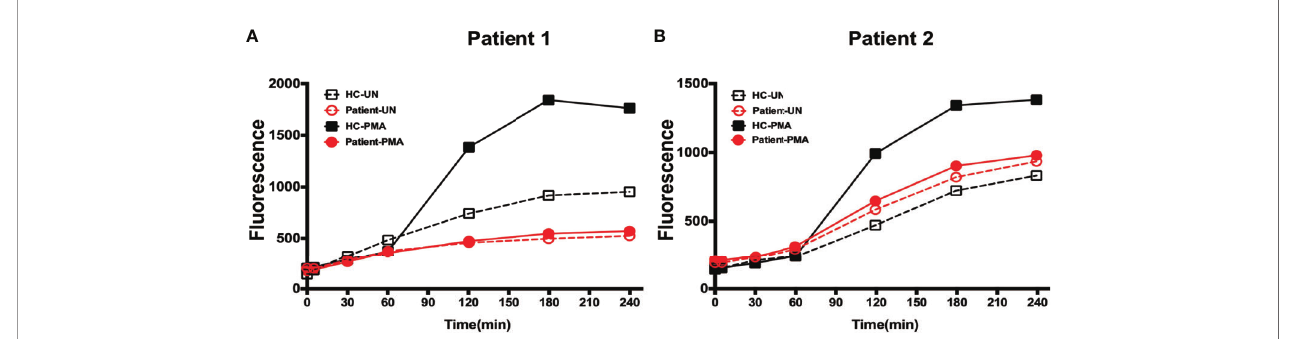
FIGURE 6 | Expulsion of NETs from neutrophils. (A) Fluorescence generated by neutrophils from patient 1 and healthy controls at each time-point following incubation in the presence or absence of PMA stimulation. (B) Fluorescence generated by neutrophils from patient 2 and healthy controls at each time-point following incubation in the presence or absence of